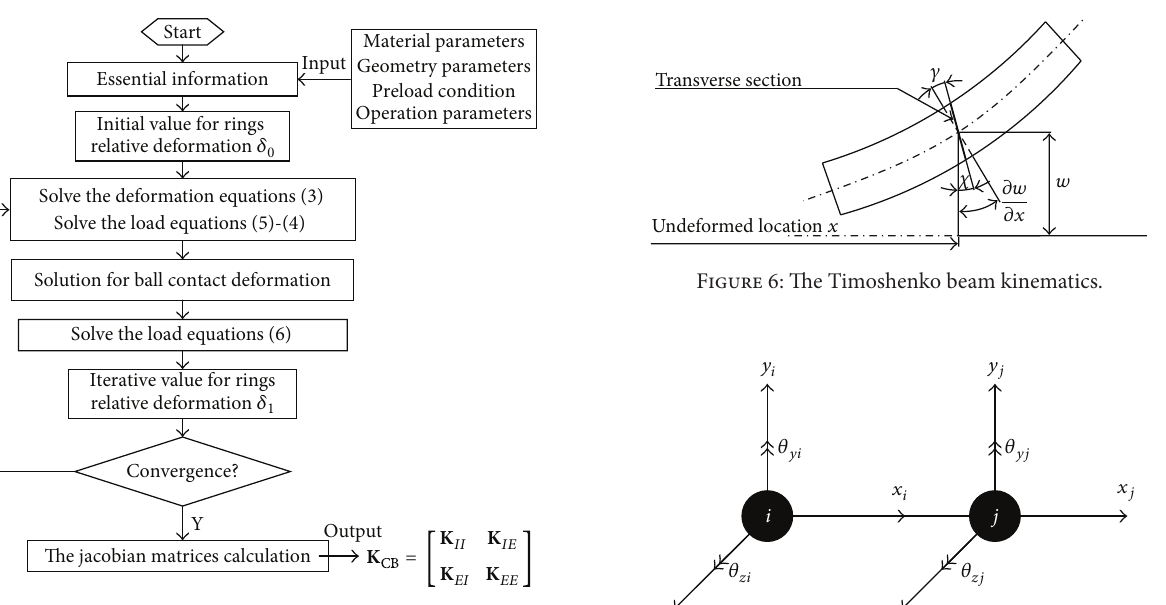
Figure 5: Flow chart of angular contact ball bearing stiffness matrix calculation procedure.